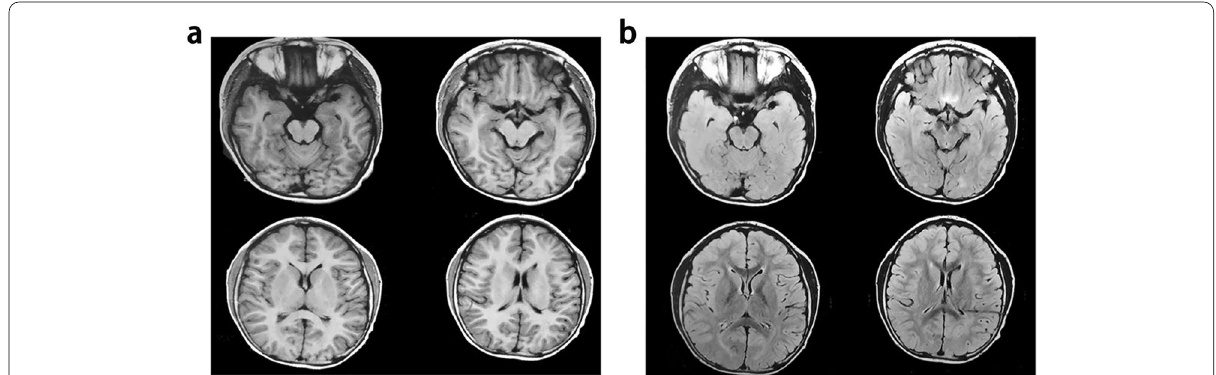
Fig. 2 MRI was performed only once at the age of 12, in 2014. T1-weighted images of 3-mm thickness ( a ) and Flair sequence images ( b ) are shown. There was a suspected focal cortical dysplasia in the right anterior temporal cortex according to the unclear boundary between gray and white matter, but this conclusion was not accepted by experts after multidisciplinary discussion